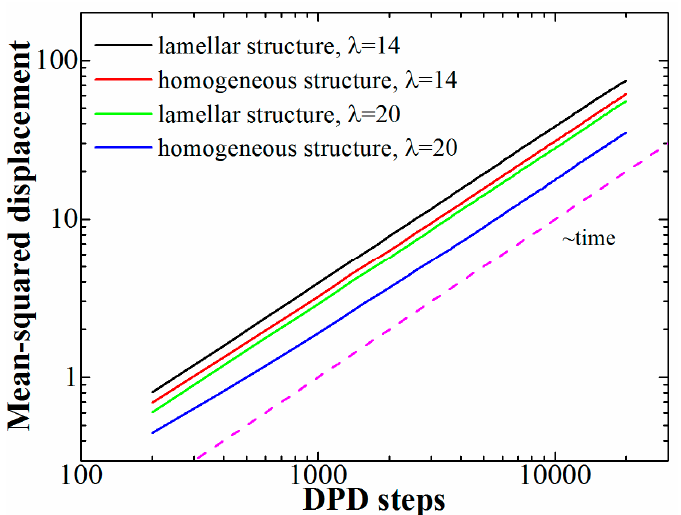
Figure 4. Mean-squared displacement of counterions at different values of λ (14 and 20) obtained for lamellar structures (diblock-copolymers) and homogeneous structures (copolymers with evenly distributed charged groups). The diffusion coefficient is reflected by the position of the curve: The higher the curve, the higher the diffusion coefficient.